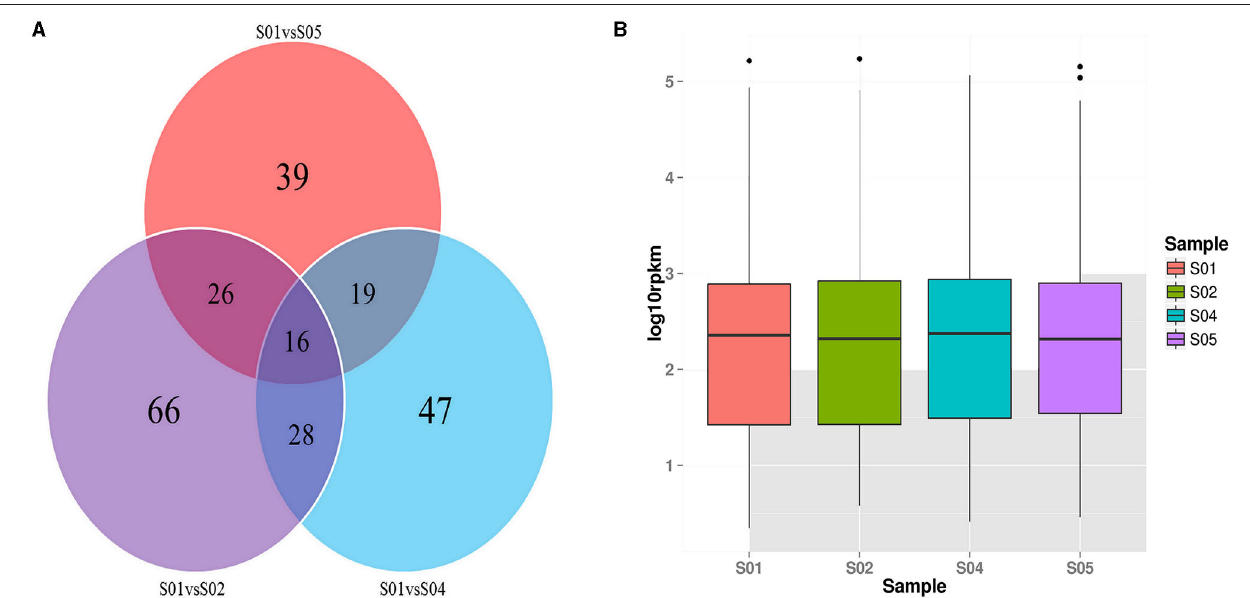
FIGURE 4 | The Venn and box plot diagrams of DE miRNAs. (A) The Venn diagrams of DE miRNAs among three groups during cold stress in the potato; (B) The box plot of overall distribution of miRNA expression in each sample.